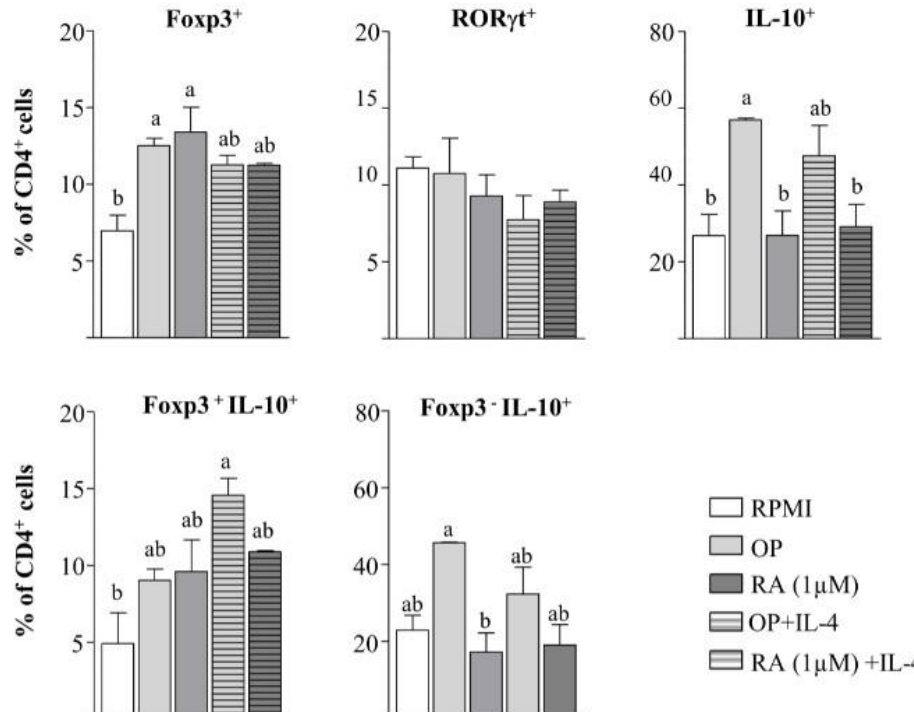
Figure 4. BM-DCs stimulated with OP enhance Foxp3 + Treg cells and Tr1 cells in co-culture with CD4 + T cells from naïve mice.BM-DCs, pre-conditioned for 24 h without stimuli (RPMI), or with OP, RA, IL-4, OP + IL-4, or RA + IL-4, were co-cultured for 2 days with spleen CD4 + T cells from naïve mice, followed by stimulation with anti-CD3 for 2 additional days. The percentage of Foxp3 + , ROR γ t + , IL-10 + , Foxp3 + IL-10 + , and Foxp3 − IL-10 − cells within the total CD4 + T cell population was assayed by flow cytometry. Results of an experiment representative of 3 separate experiments performed in triplicate are shown. Data are means ± SEM. Di ff erent letters indicate statistically significant di ff erences ( p < 0.05) calculated using one-way ANOVA, followed by Tukey’s post-hoc test.